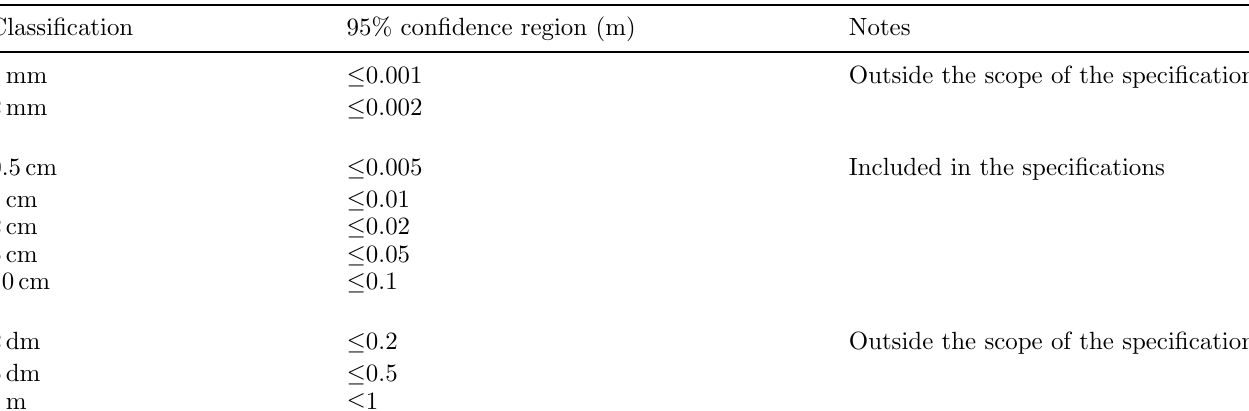
Table 1. Classi fi cation of a GNSS control network based on SU as described in the Australian standards [27]. Classi fi cation Survey uncertainty (SU) Horizontal position (mm) Ellipsoidal height (mm) Below 15 mm (horiz.) and 20 mm (vert.) < 15 Below 30 mm (horiz.) and 50 mm (vert.) Table 2. Classi fi cation of a GNSS control network based on the Californian standards [28]. Classi fi cation 95% con fi dence region